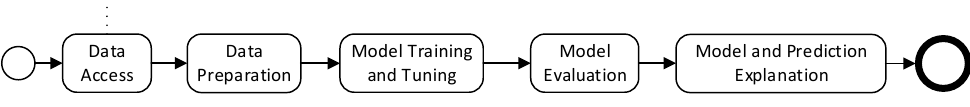
Figure 1. Methodology.